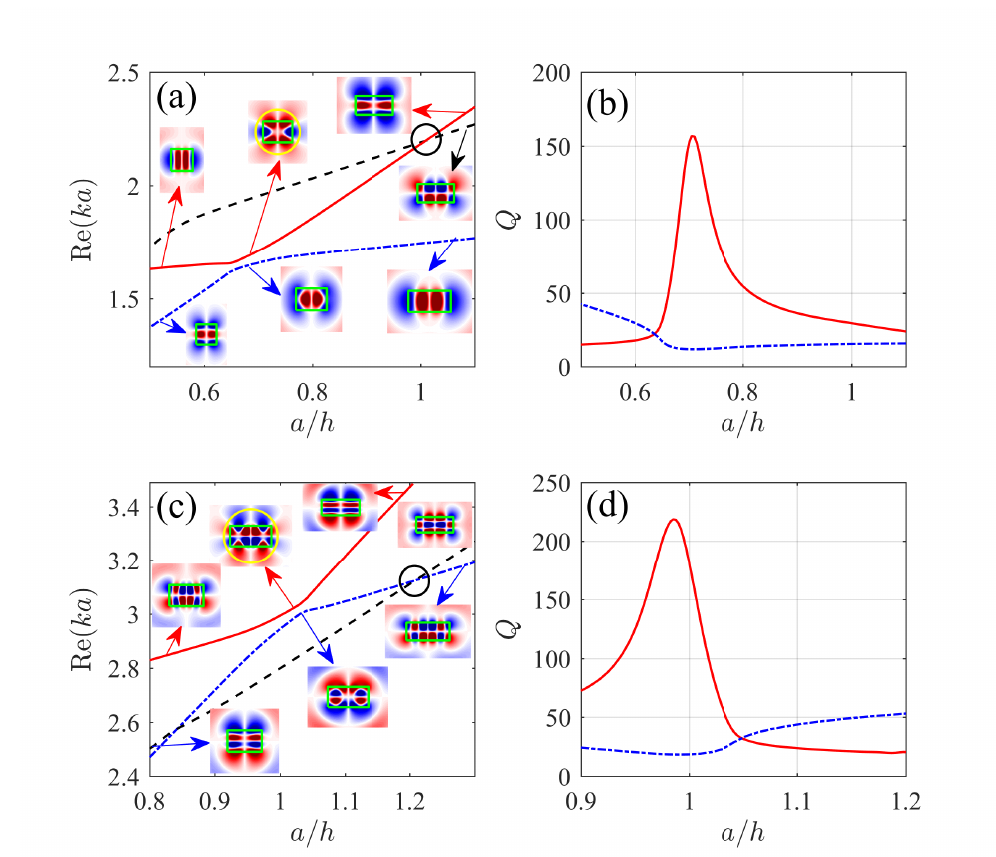
Figure 2. ( a ) Avoided crossing of two TE resonances (red and blue solid lines) whose modes are symmetric relative to z → − z versus the aspect ratio a / h in isolated silicon disk. The anti-symmetric resonant mode shown black dash line is not involved into avoided crossing. Insets show evolution of hybridized mode (the tangential component of electric field E φ ). ( b ) The behavior of the Q factor of the corresponding resonances vs aspect ratio. ( c ) Avoided crossing of two anti-symmetric (red and blue dash lines) TE resonances. The symmetric resonant mode shown black solid line does not participate in avoided crossing. ( d ) The Q factors vs aspect ratio.